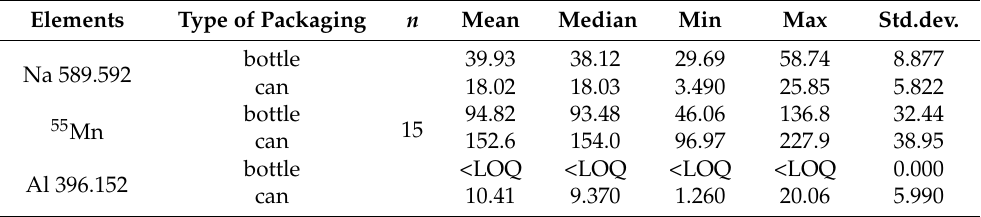
Table 4. Contents of selected elements (with statistically significant differences) in the measured set of samples ( n = 30; bottles n = 15, cans = 15) in reference to the impact of packaging material [mg/L].